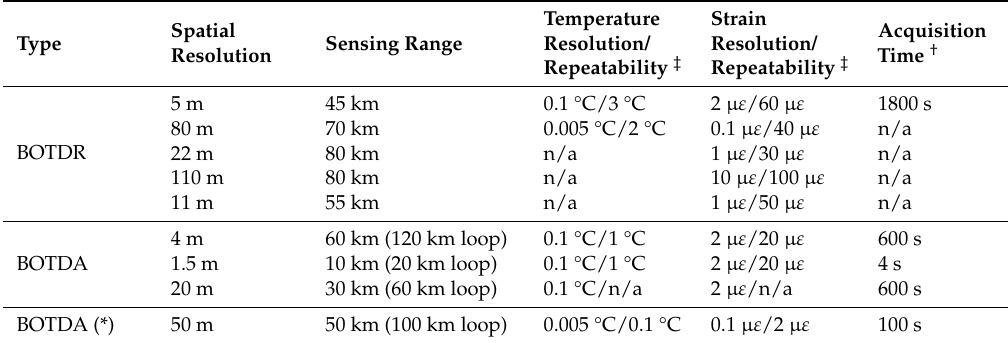
Table 3. Performances of some commercial BOTDR/BOTDA systems (sources: producers’ datasheets, technical notes, and scientific